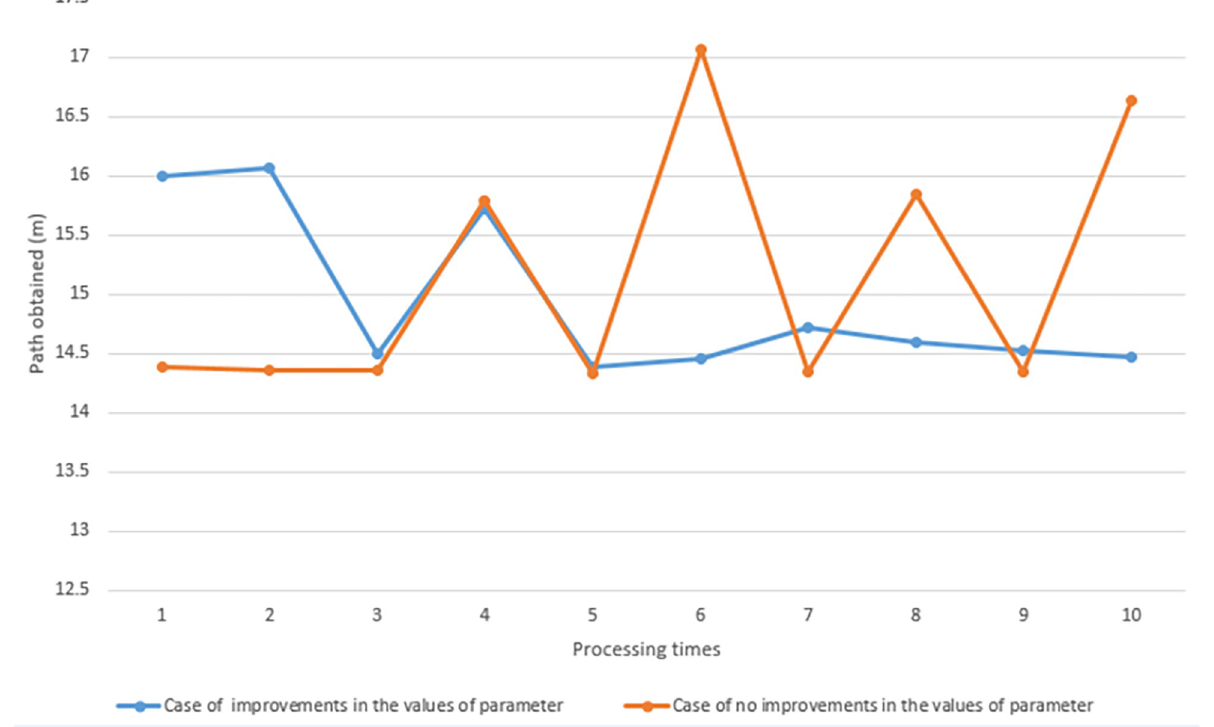
Fig 11. Comparison of path obtained from the proposed